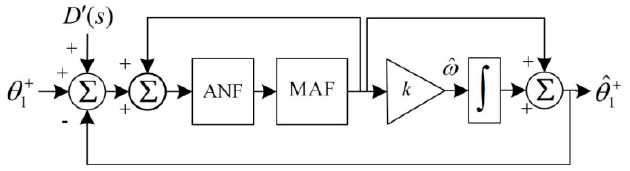
Figure 12. The simplified model of the proposed structure.